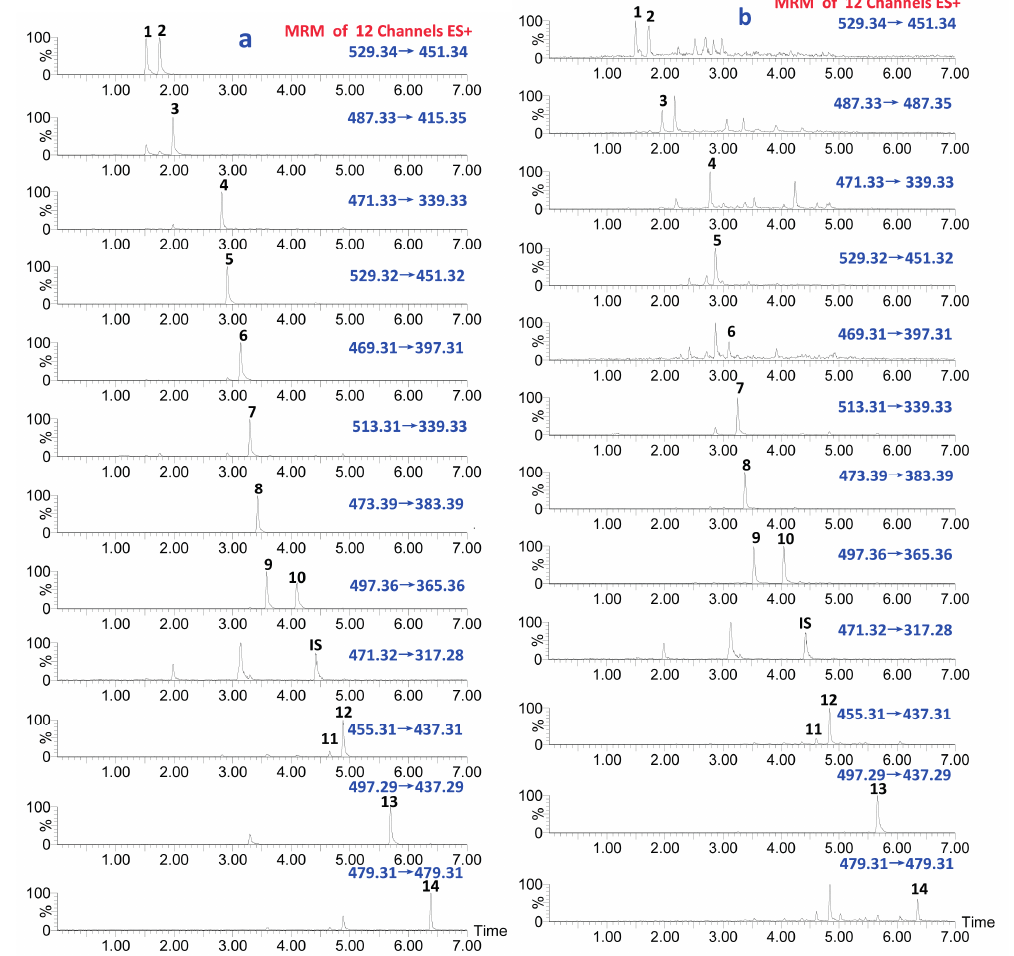
Figure 6. UPLC-QqQ MS MRM chromatogram in positive ion mode of ( a ) fourteen target standards and ( b ) sample of